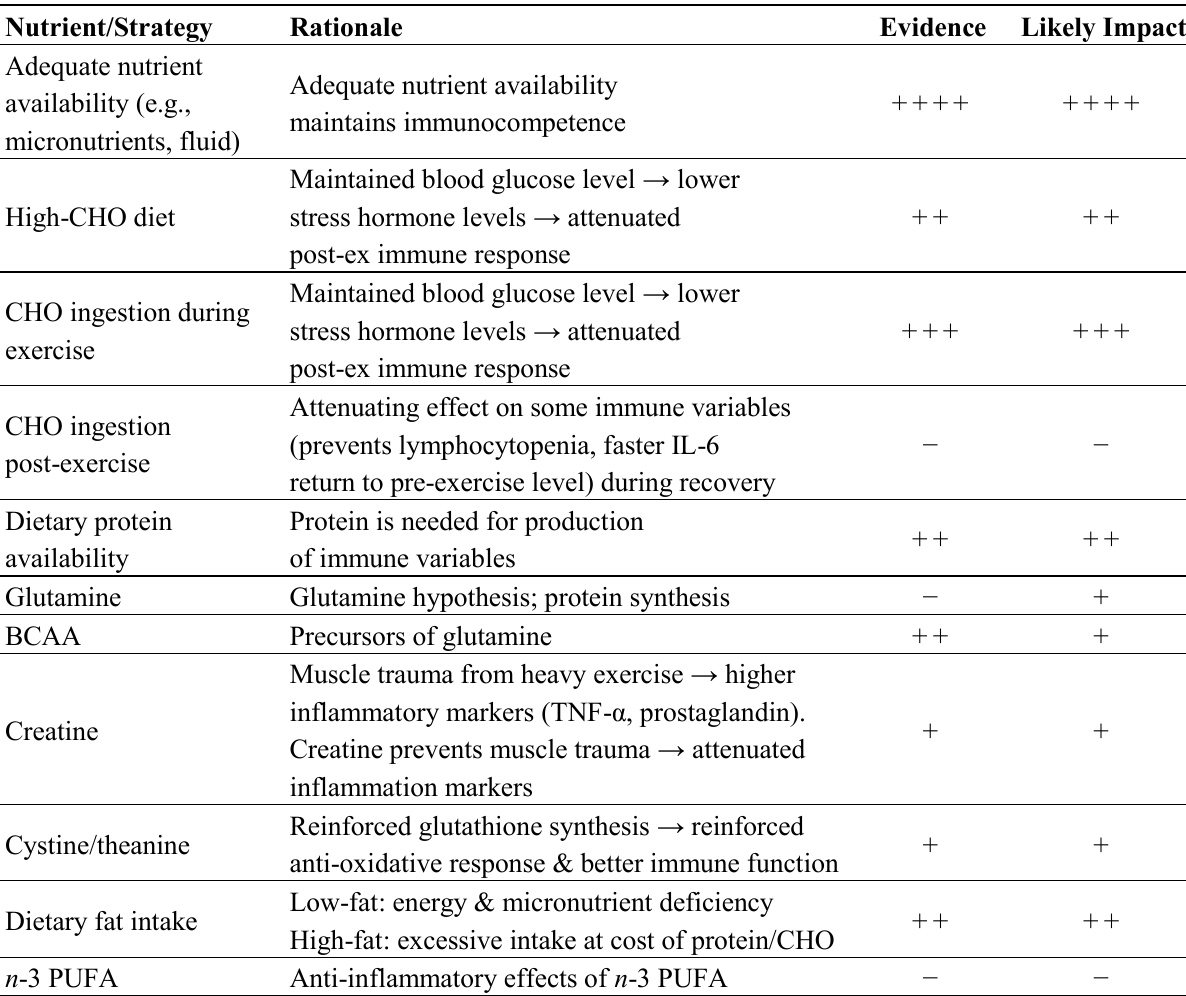
Table 3. Immunomodulating nutritional strategies & countermeasures: evidence and likely impact (CHO: carbohydrate; BCAA: branched chain amino acid; n -3 PUFA: Omega-3 polyunsaturated fatty acids; evidence for rationale: −: no evidence; +: very limited evidence exists—more research is needed; ++: limited evidence exists—more research